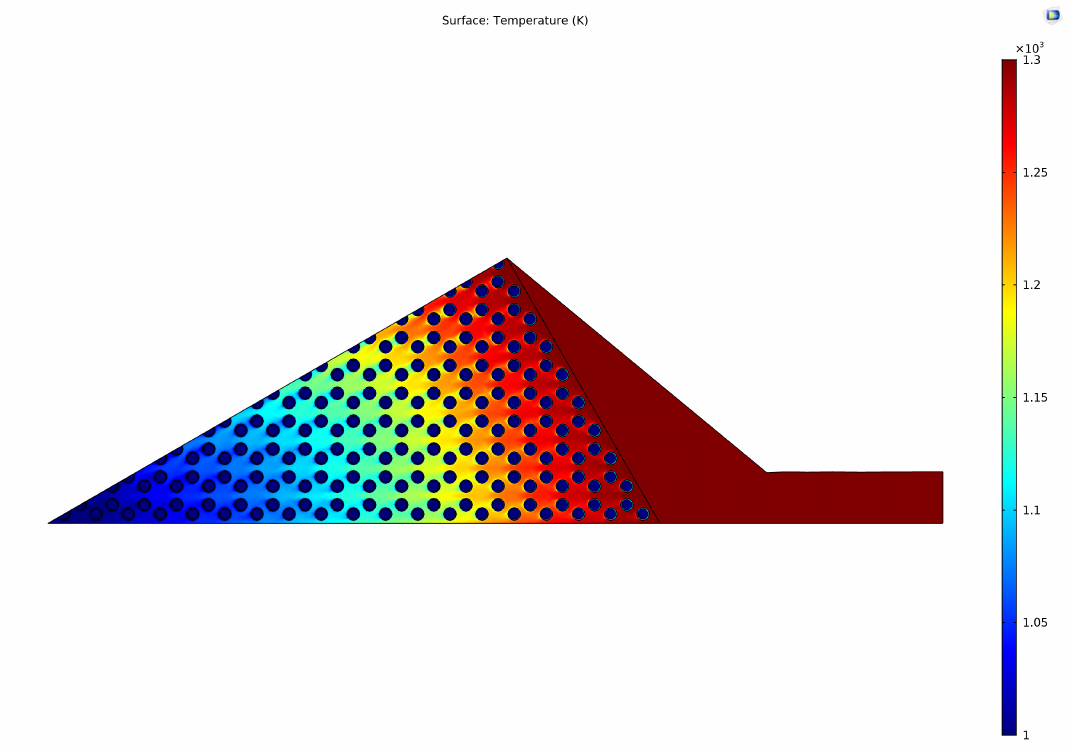
Figure 14. Temperature distribution at the plane of the fuel inlet